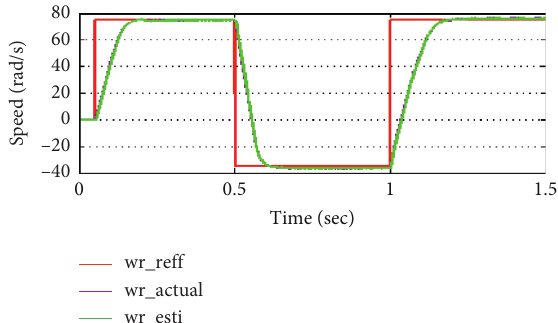
Figure 12: Step response of drive with speed reversal with load.